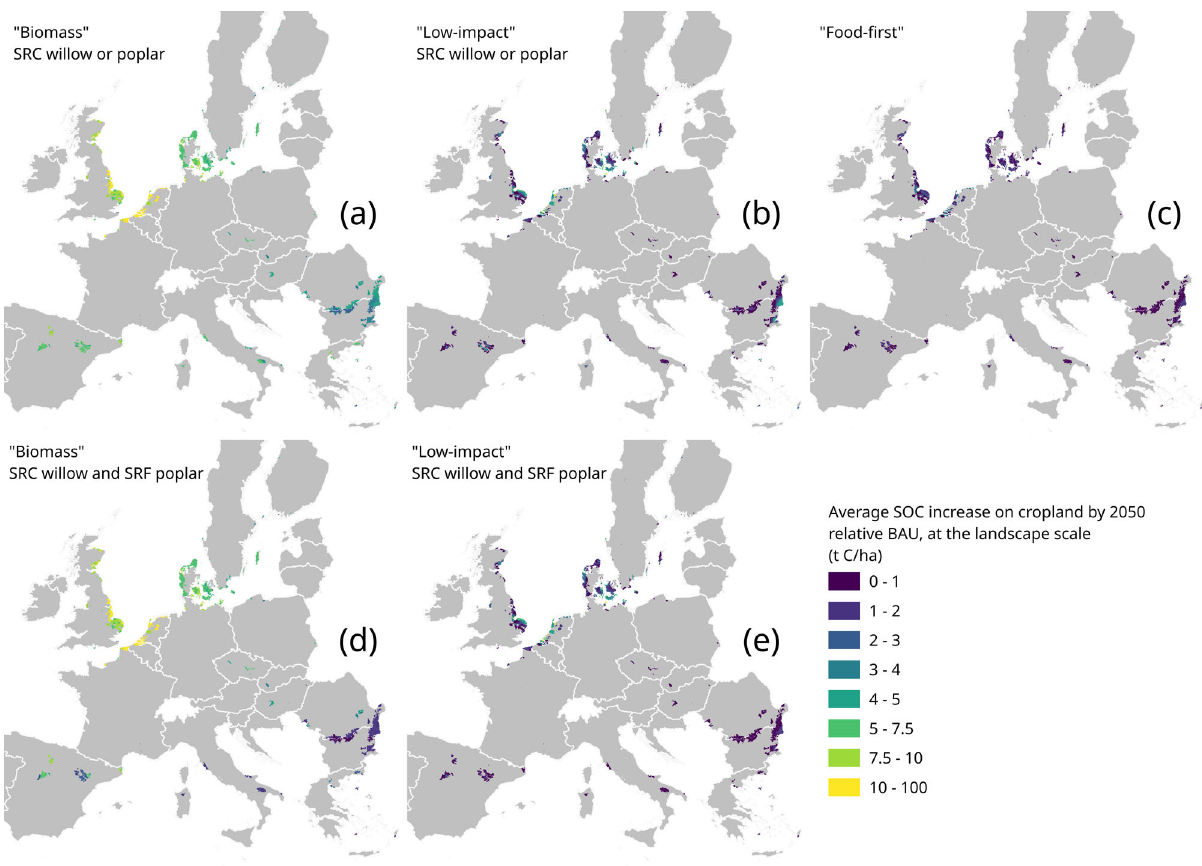
Fig. 5 Increase in soil organic carbon due to implementation of windbreaks. Average increase in SOC on cropland by 2050, relative a business-as-usual (BAU) scenario with continued existing land-use, in each landscape, for the different deployment scenarios ( a – e ), and different windbreak options for the Biomass ( a , d ) and Low-impact ( b , e )